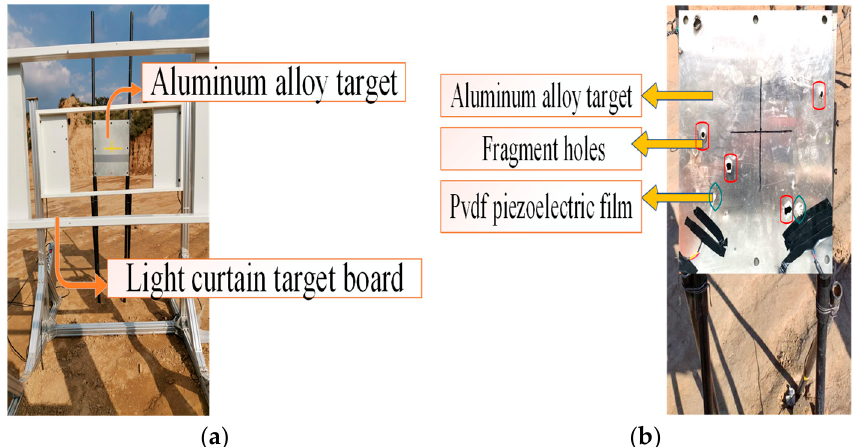
Figure 8. Evasion of the slurry target. ( a ) Evasion hit target board experimental device. ( b ) Evasion of the target results.